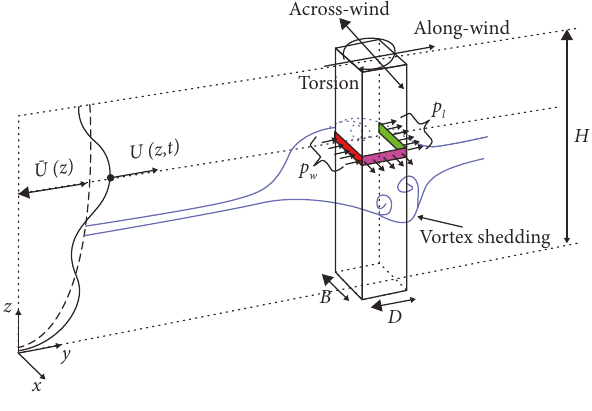
Figure 1: Wind-induced responses of tall